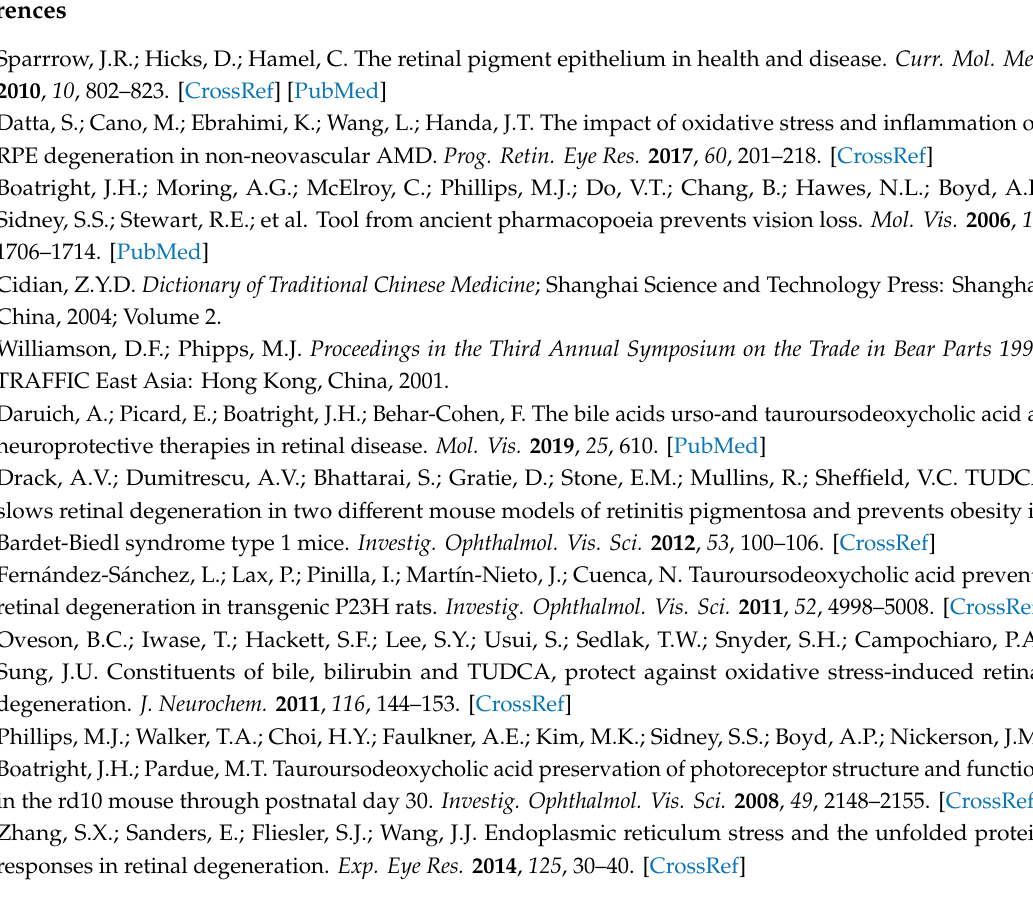
Figure S1: Protection of TUDCA against oxidative damage was mediated by NRF2. NRF expression in control, H 2 O 2 , and H 2 O 2 -plus-TUDCA-treated cells was measured by qRT-PCR, Table S1: Primers for